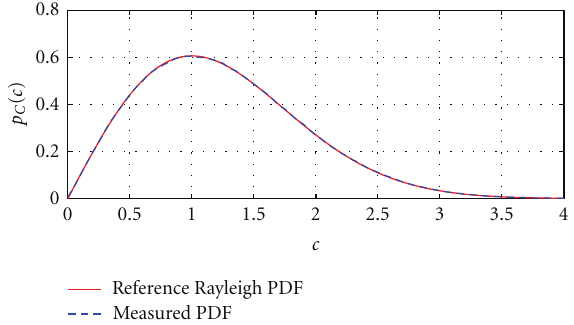
Figure 3: PDF of the generated fading samples with f D = 200 Hz, F s = 10